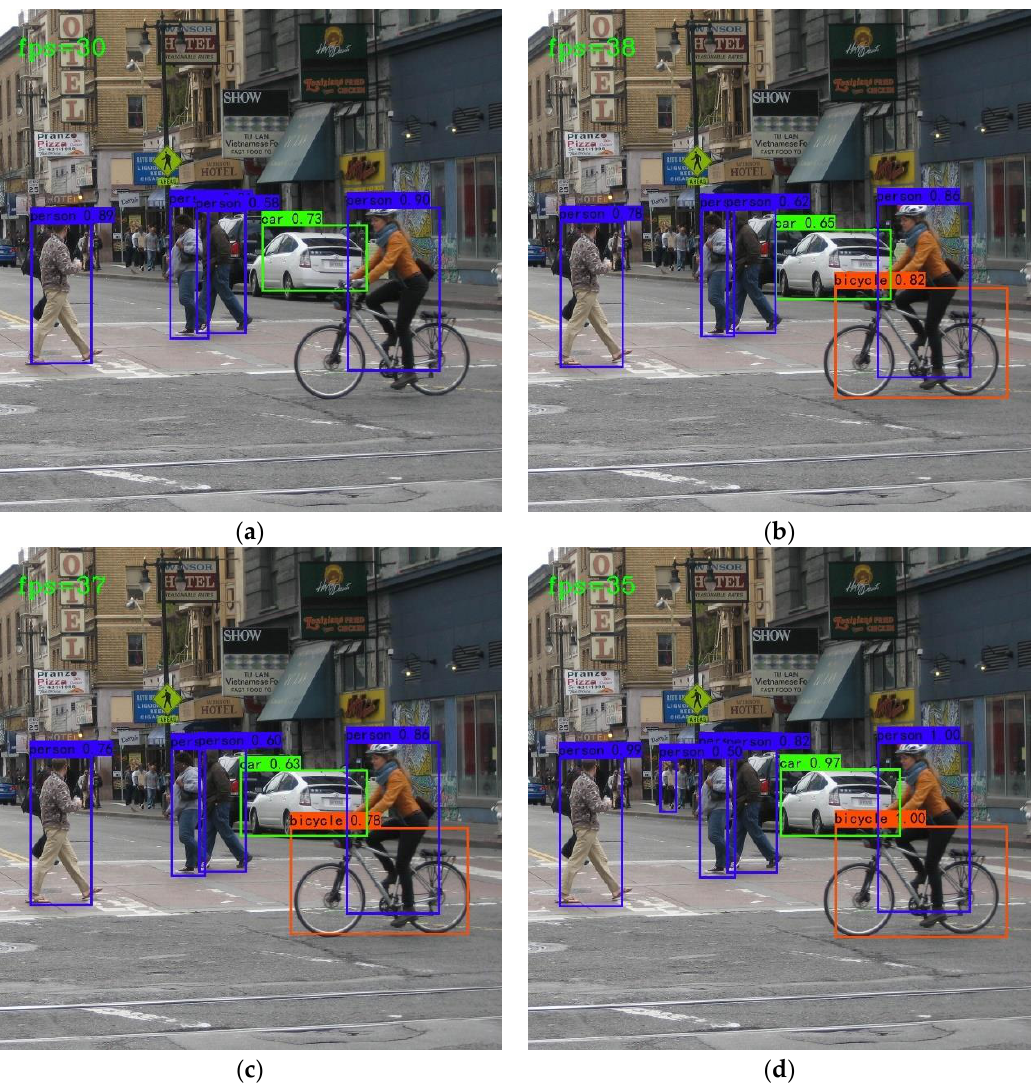
Figure 9. Detection Examples of the above model. The above four pictures are the detection results of the four models, respectively. ( a ) is result of Model 1, ( b ) is result of Model 2, ( c ) is result of Model 3, and ( d ) is result of Model 4.